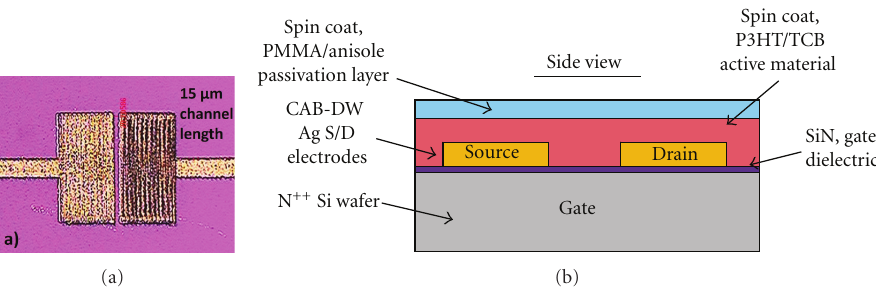
Figure 21: (a) Optical micrograph of Ag source and drain electrodes deposited by CAB-DW on SiN x -coated Si wafer with a channel length